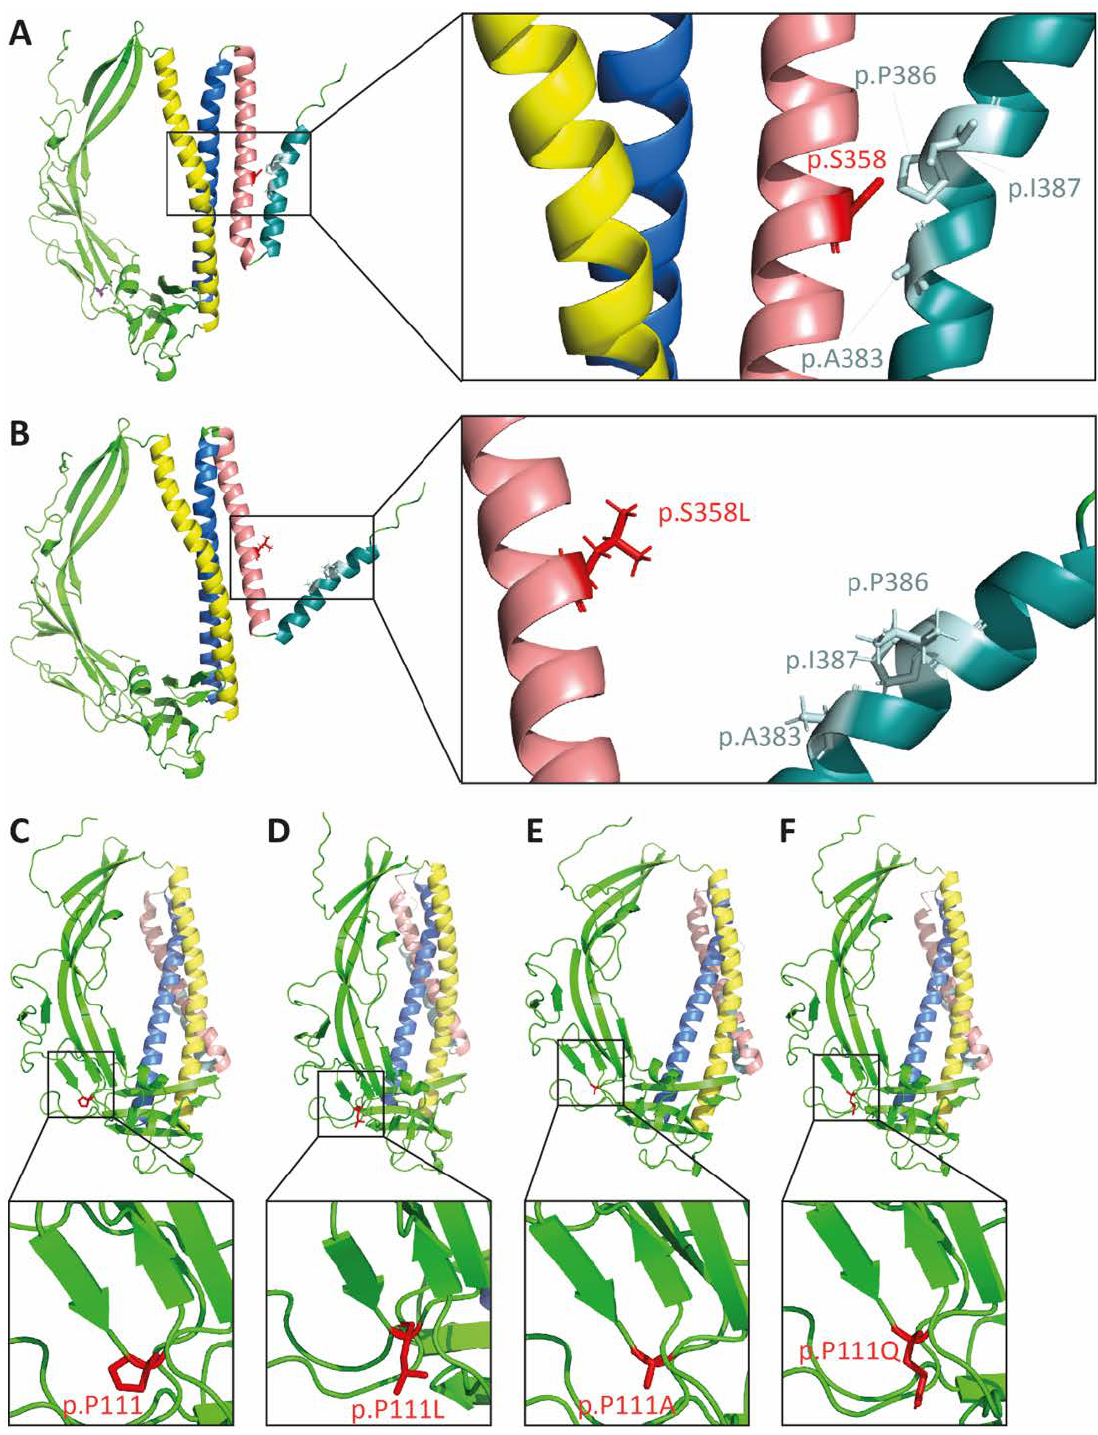
Figure 1. The p.S358L variant changes protein conformation of TMEM43. In silico modeling of TMEM43 tertiary structure of wild-type ( A , C ) and proteins with the corresponding missense mutations ( B ) p.S358L, ( D ) p.P111L, ( E ) p.P111A, and ( F ) p.P111Q. Yellow indicates transmembrane domain (TMD) 1, blue indicates TMD2, rose indicates TMD3, and turquoise indicates TMD4. The residue of interest is indicated in red (p.S358 in A and B ; p.P111 in C – F ).